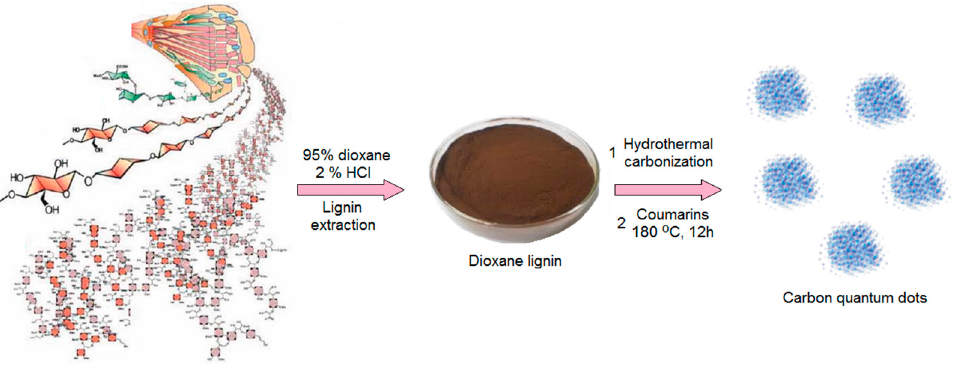
Figure 1 . General strategy for carbon quantum dots (CQDs) preparation .